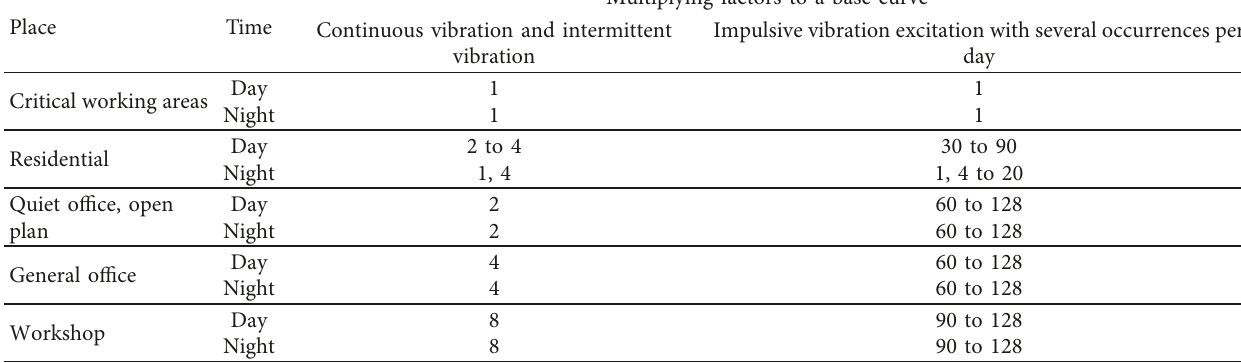
Table 2: Multiplying factors used in several countries to specify satisfactory magnitudes of building vibration with respect to a human response